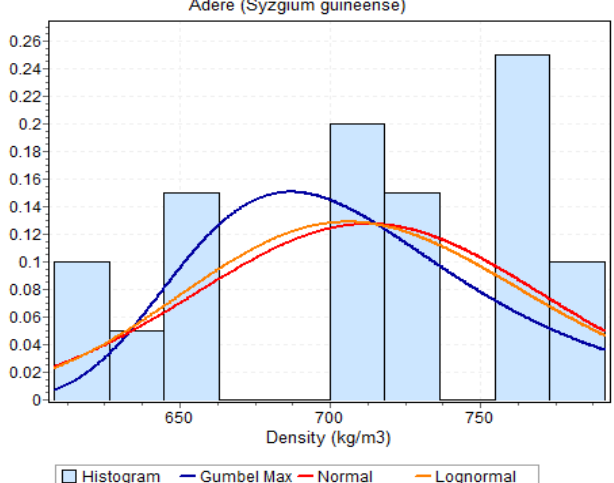
Fig. 6. Probability Density Function Plots for Density of Syzium